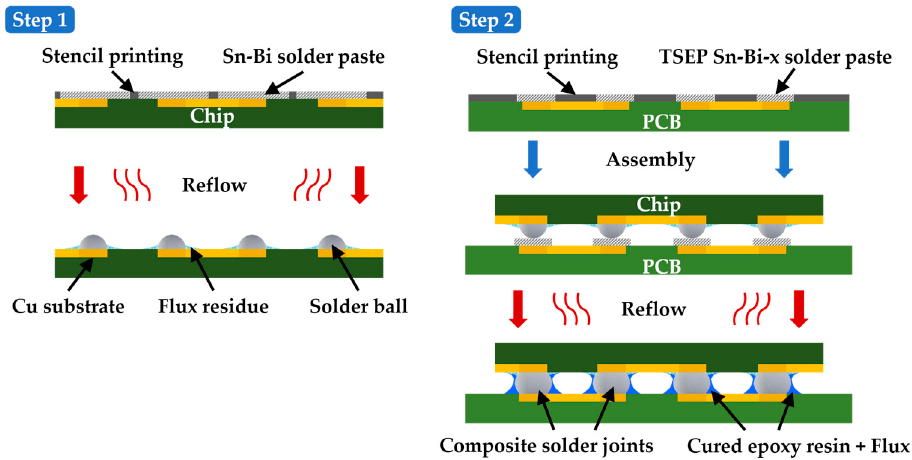
Figure 2. Schematic diagram of the drop test specimen preparation process.